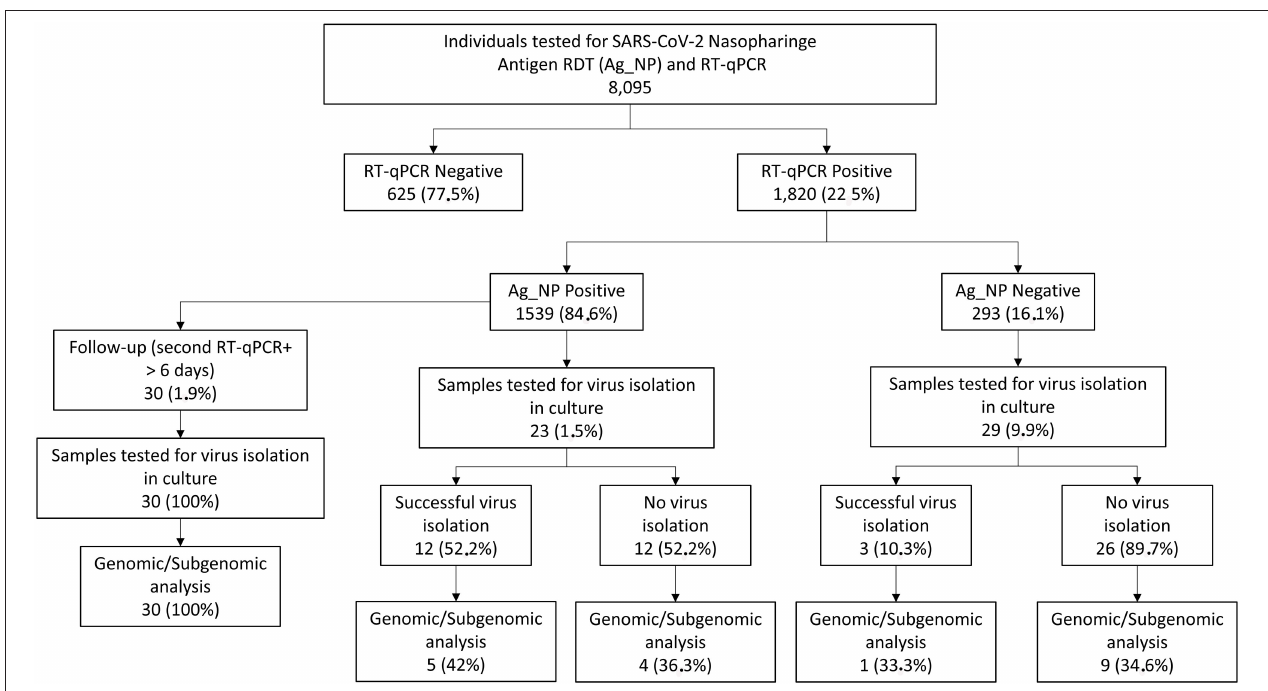
FIGURE 1 | Schematic representation of the UFRJ-CTD cohort from 20 August to 21 September and sample selection. Mildly symptomatic individuals tested for severe acute respiratory syndrome-related coronavirus (SARS-CoV-2) diagnosis at the Center for COVID-19 Diagnosis of Federal University of Rio de Janeiro from August 2020 to September 2021 account for a total of 8.095 RT-qPCR and antigen RTD exams. Of this total, 1.820 tested positive for SARS-CoV-2 1.539 also being antigen RDT positive (concordant samples) and 293 antigen RDT negative (discordant samples). From this group, 61 samples (23 concordant and 29 discordant) were selected for further studies comprising the cross-sectional dataset while 30 additional patients were selected for the follow-up dataset where the patient has a second sample collected with a minimum of 6 days after